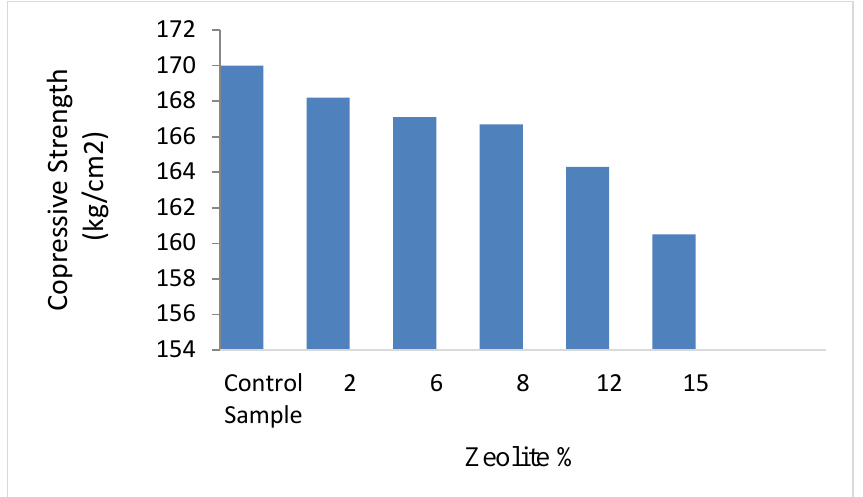
Fig. 9. Concrete strength with different percentages of Zeolite with 340 grade cement at 7 days old concrete.